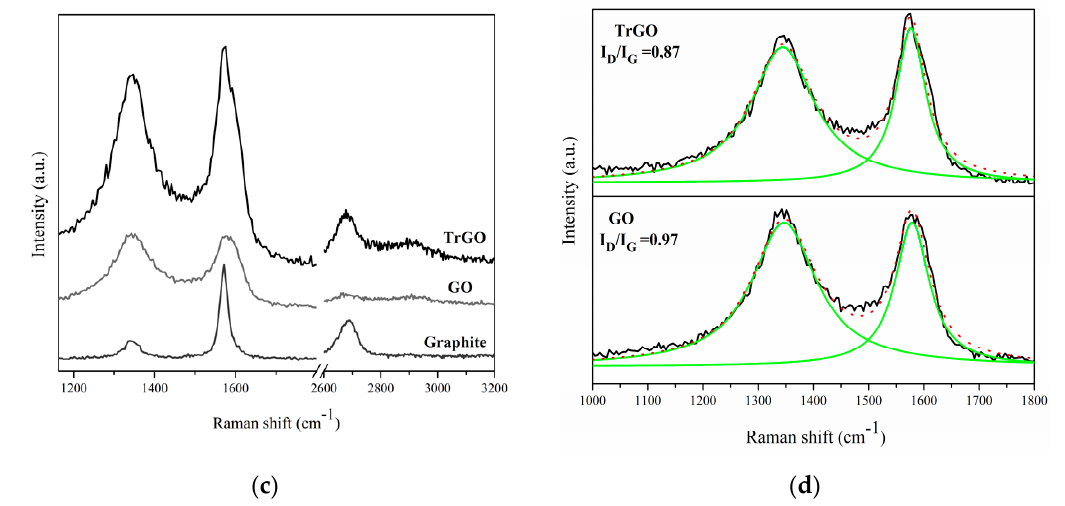
Figure 2. Characterization of graphene-based particles: ( a ) X-ray diffractogram; ( b ) pseudo-Voigt adjustment from high-resolution XPS spectra of TrGO and GO particles; ( c ) Raman spectra; and ( d ) intensity ratio (I D / I G ) by Lorentzian curve adjustments.